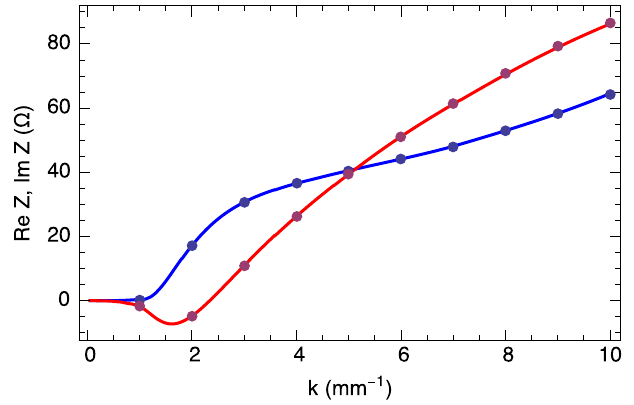
FIG. 9. Wiggler impedance: comparison of analytical calcu- lations (shown by dots) with computer simulations (shown by solid lines). Re Z is shown in blue and Im Z in red.